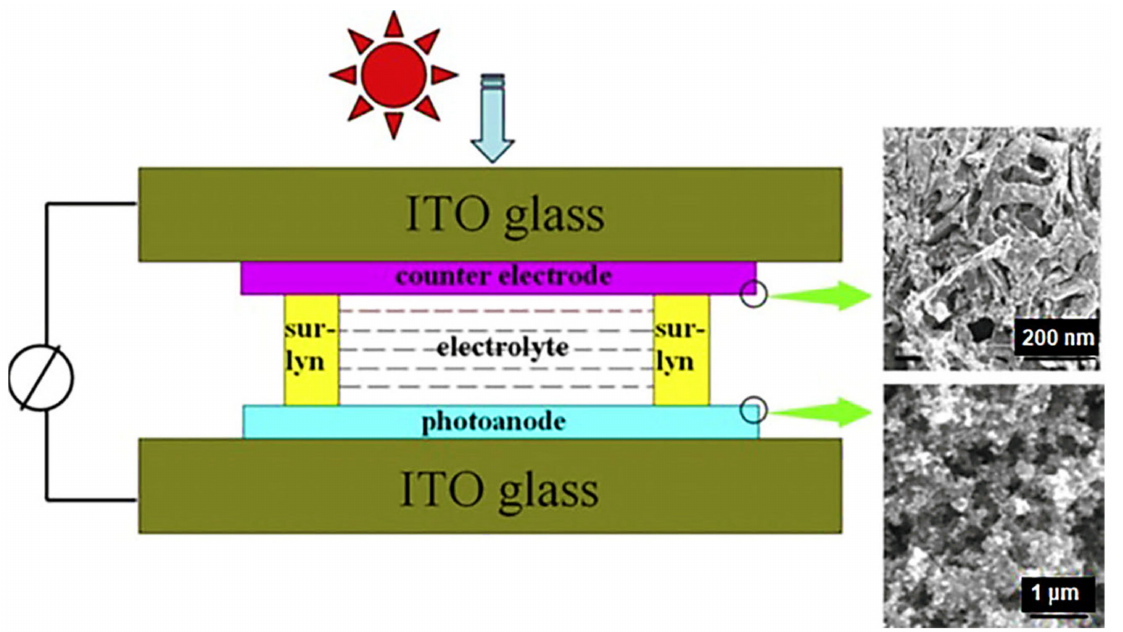
Figure 12. DSSC with graphene-nanofoam-based photoanode. DSSC = dye sensitized solar cell. Reprinted with permission from Ref. [99]. 2013,